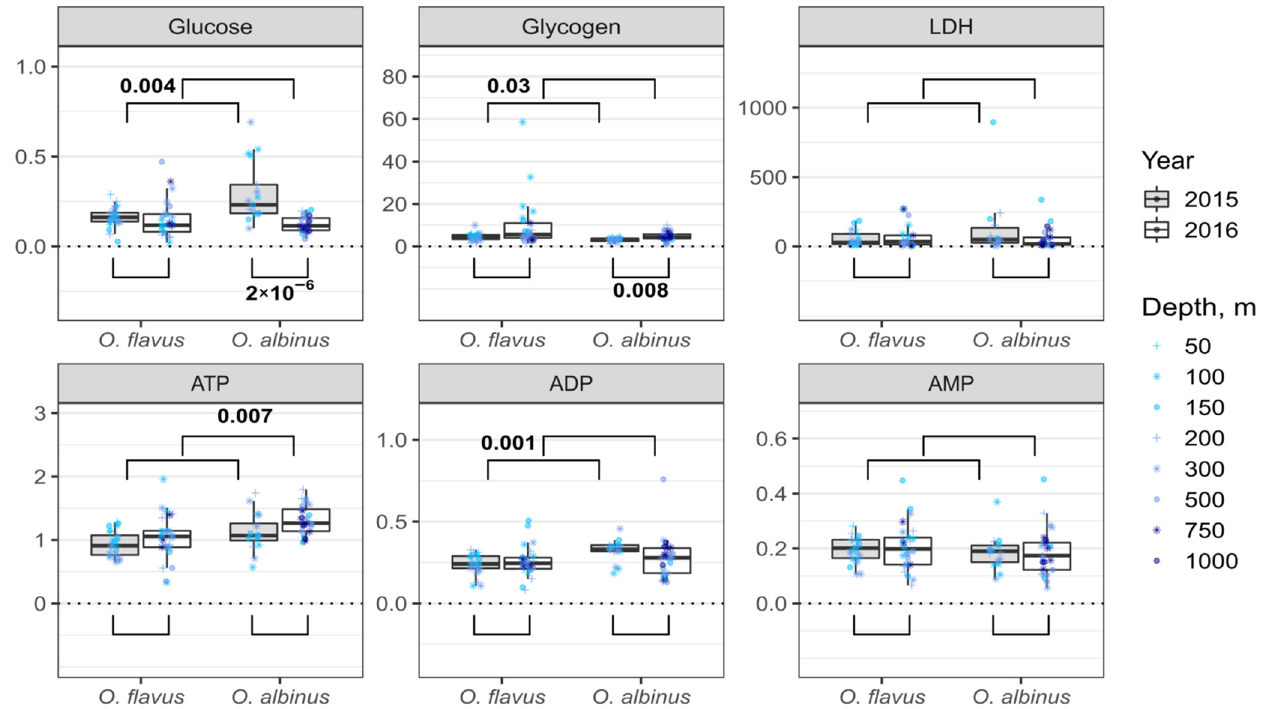
Figure 2. Energy-related biochemical parameters in O. flavus and O. albinus fixed right after collection from deep-water traps. Measurements for amphipods from all depths were pooled within each sampling year; n = 27–30 for O. flavus and n = 21–26 for O. albinus . Values are expressed as µ mol g − 1 of tissue for adenylates, glucose and glycogen (glucose-corrected) reserves, and as nkat mg − 1 for LDH activity. The numbers near the brackets indicate p -values for respective pairwise comparisons if the difference is statistically significant (Mann–Whitney U-test with Holm’s correction for multiple comparisons). A similar comparison that only includes the samples from 100–300 m is presented in Figure S2.